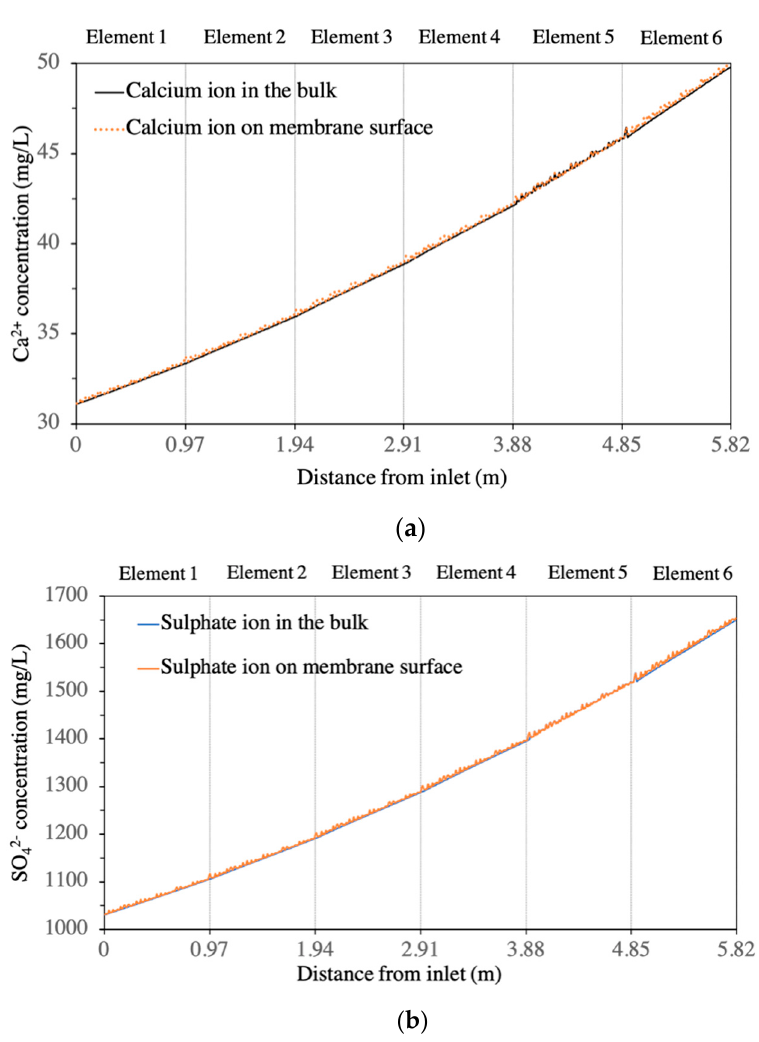
Figure 4. Calcium and sulphate ion concentrations in both bulk solution and membrane surface of the 6 elements in the 1st stage: ( a ) calcium ion; ( b ) sulphate ion.